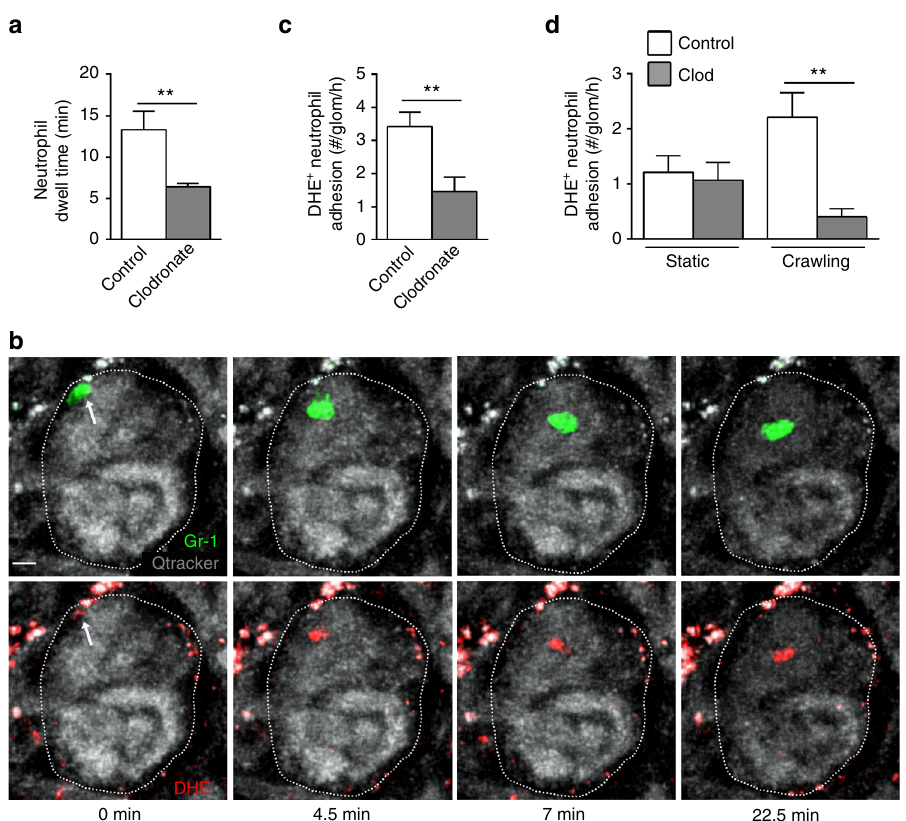
Fig. 8 Monocytes are required for T-cell-induced neutrophil activation in response to planted antigen. The effect of clodronate liposome-mediated monocyte depletion on glomerular neutrophil retention and activation was assessed 24 h after transfer of OT-II cells and 8D1/pOVA via intravital multiphoton microscopy. Mice were treated with either control liposomes (white bars) or clodronate liposomes (gray bars) 18 h prior to cell transfer. a Neutrophil dwell time in control and clodronate liposome-treated mice. b – d Production of reactive oxygen species (ROS) by neutrophils, as assessed in intravital microscopy experiments via the ROS-sensitive fl uorochrome, dihydroethidium (DHE). b Multiphoton image sequence showing a neutrophil (arrow) (identi fi ed by Gr-1 staining, green, upper panels) positively stained for DHE (red, lower panels). Time elapsed is shown beneath each panel. See also Supplementary Movie 11. c Number of DHE + neutrophils adherent in the glomerular capillaries shown for the total population ( c ) and separately for static and crawling neutrophils ( d ). Data are shown as mean ± s.e.m. from seven mice per group. ** P < 0.01 vs Control. a , d Mann − Whitney tests;